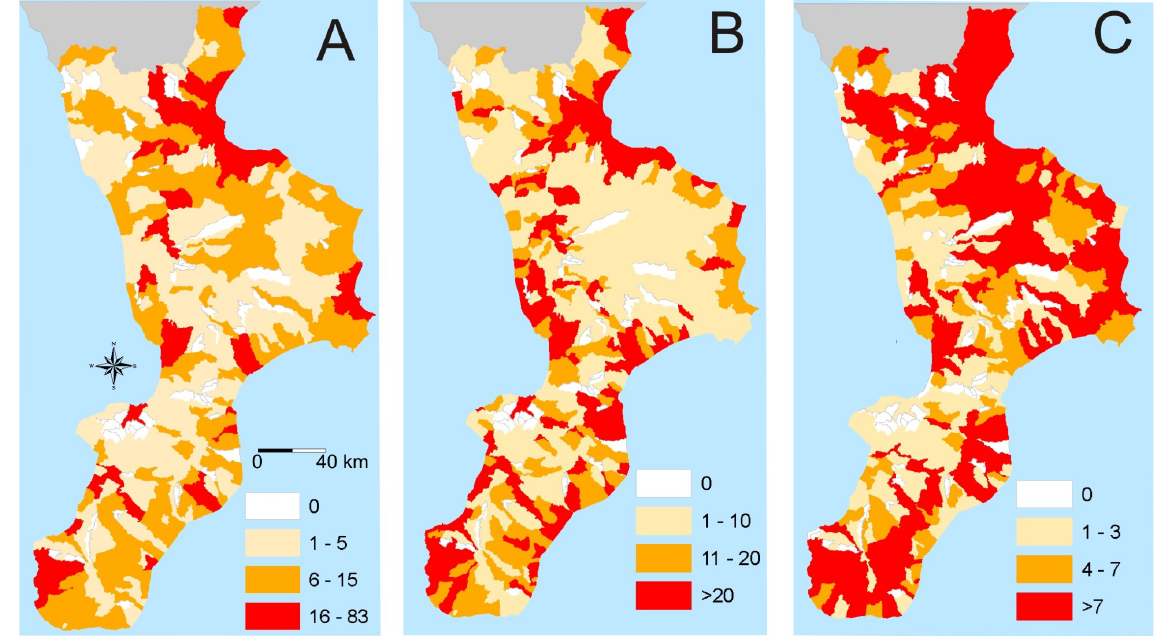
Fig. 3. Maps of total municipality flood number. (A) Total number of floods (TNF); (B) density: TNF divided by municipality area (TNF 100km − 2 ) ; (C) TNF per population density (TNF 100km 2 inhabitants − 1